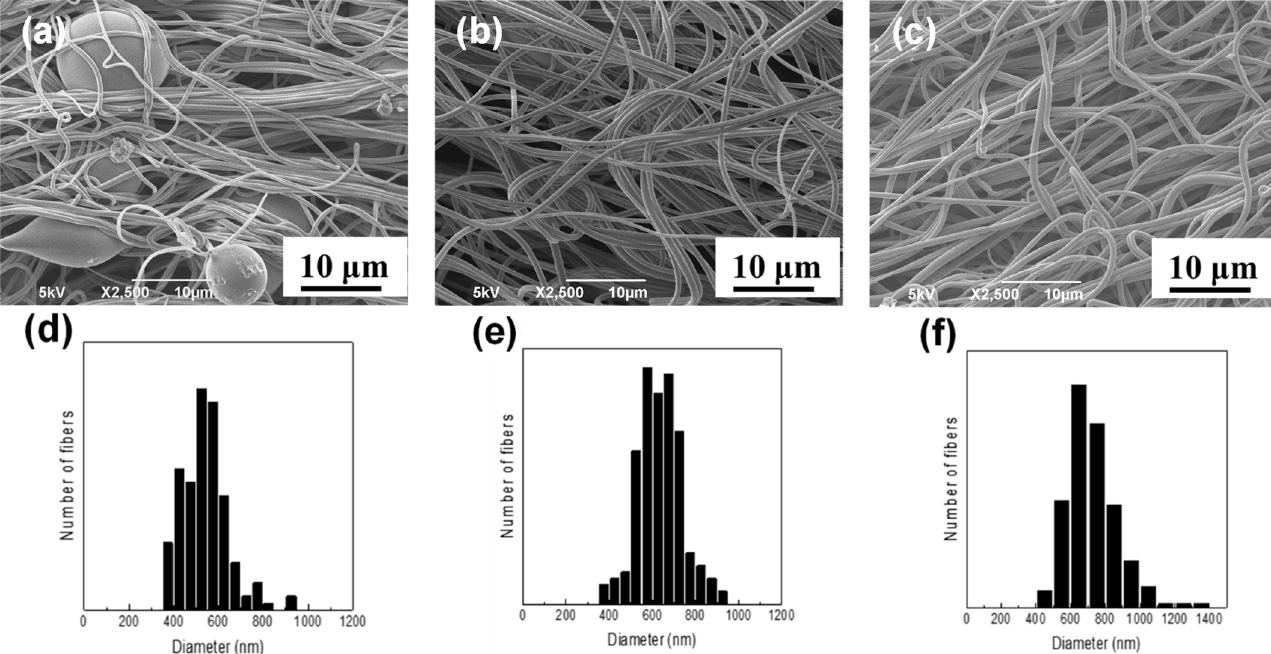
Figure 4. Typical surface SEM images and fiber diameter distributions of the randomly-deposited NFs prepared by SBS from 10 wt % Nafion/MeOH solutions containing PEO at the flow rate of 1.0 mL h − 1 . The compositions of the Nafion/PEO composite NFs are ( a ) 99.5/0.5, ( b ) 99/1, and ( c ) 98.5/1.5. ( d – f ) Corresponding fiber diameter distributions of parts ( a – c ), respectively, from the SEM image analysis. For each NF, at least 100 measurements were carried out.